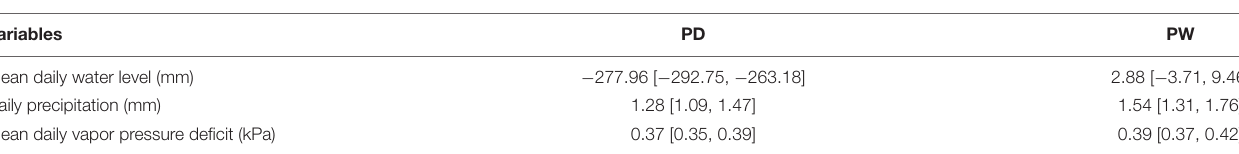
TABLE 1 | Mean values of daily water level and meteorological variables for PD and